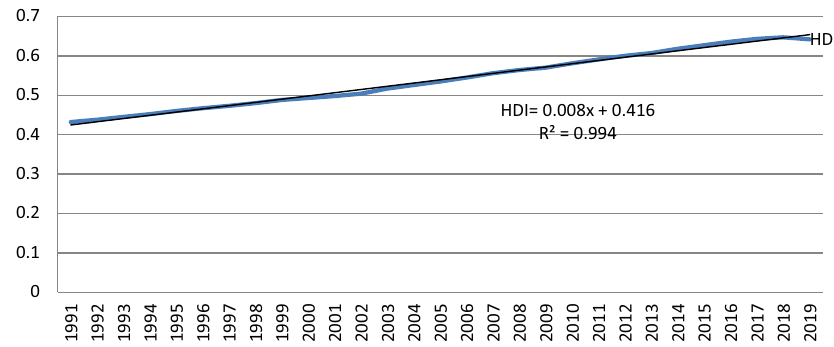
Fig. 2 Trends of human development index (Source: author’s illustration based on UNDP